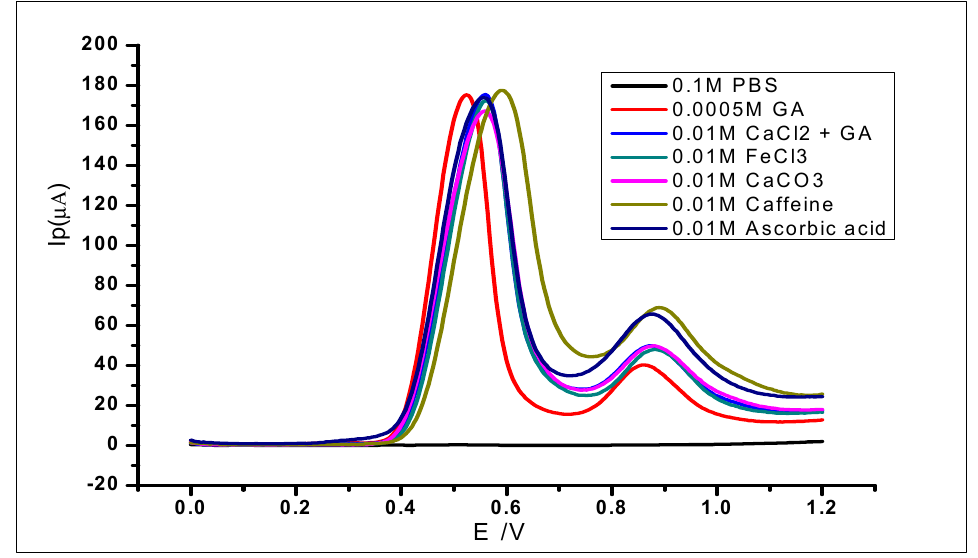
Figure 16. DPV voltammograms of 5 × 10 − 4 mol L − 1 gallic acid with di ff erent concentrations of known. Table 2. E ff ects of various substances on the determination of 1 × 10 − 3 mol L − 1 gallic acid. Interfering Species